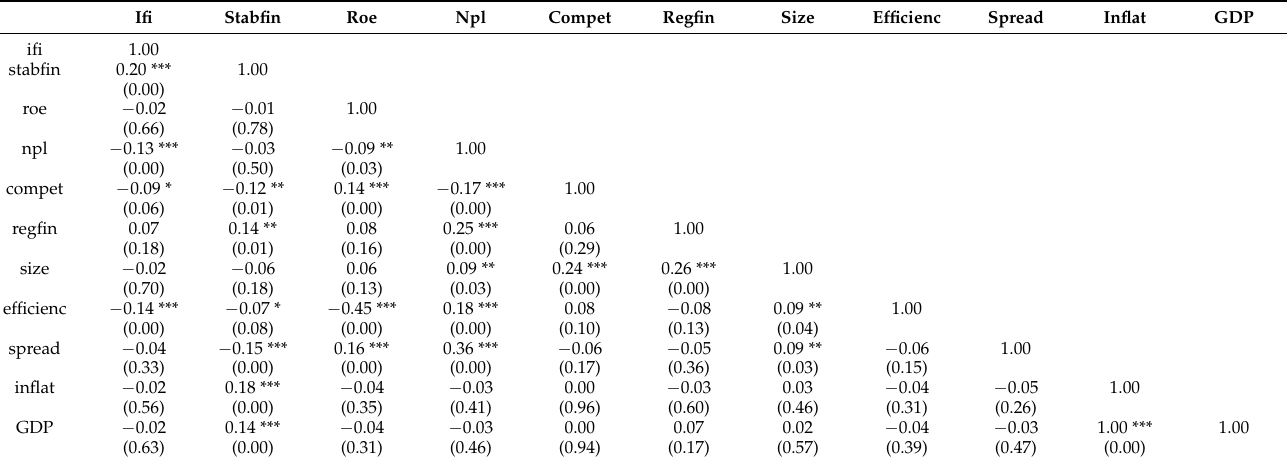
Table A2. Correlation matrix for all variables included in the study sample of SSA countries.